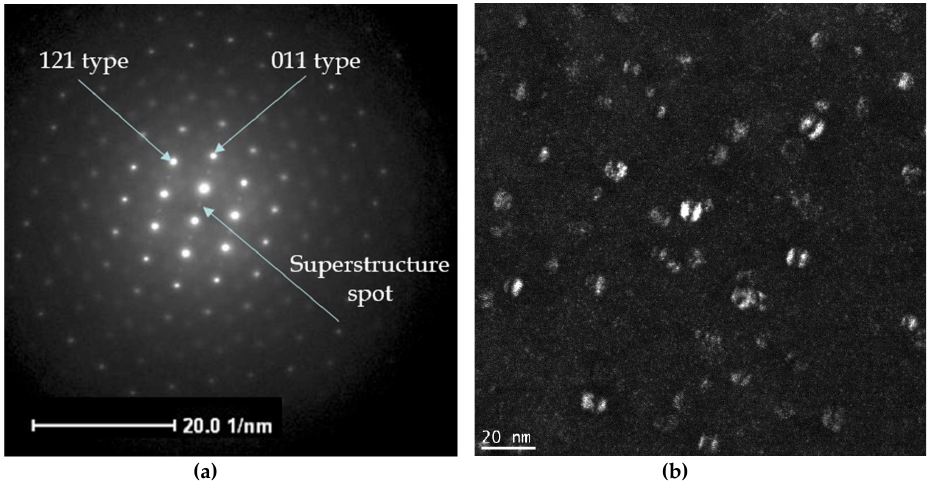
Figure 3. ( a ) BCC diffraction pattern with weaker superlattice spots. The orientation of the plane is (311). Brighter spots correspond to the Nb base BCC diffraction pattern plus precipitates, weaker spots only to the diffraction pattern of the precipitates. ( b ) Image of the particles based on the selection of a superlattice spot (dark field image). The two-hemispheric contrasts associated to each particle correspond actually to the strain field around the precipitates. The size of the precipitates is typically below 15 nm.